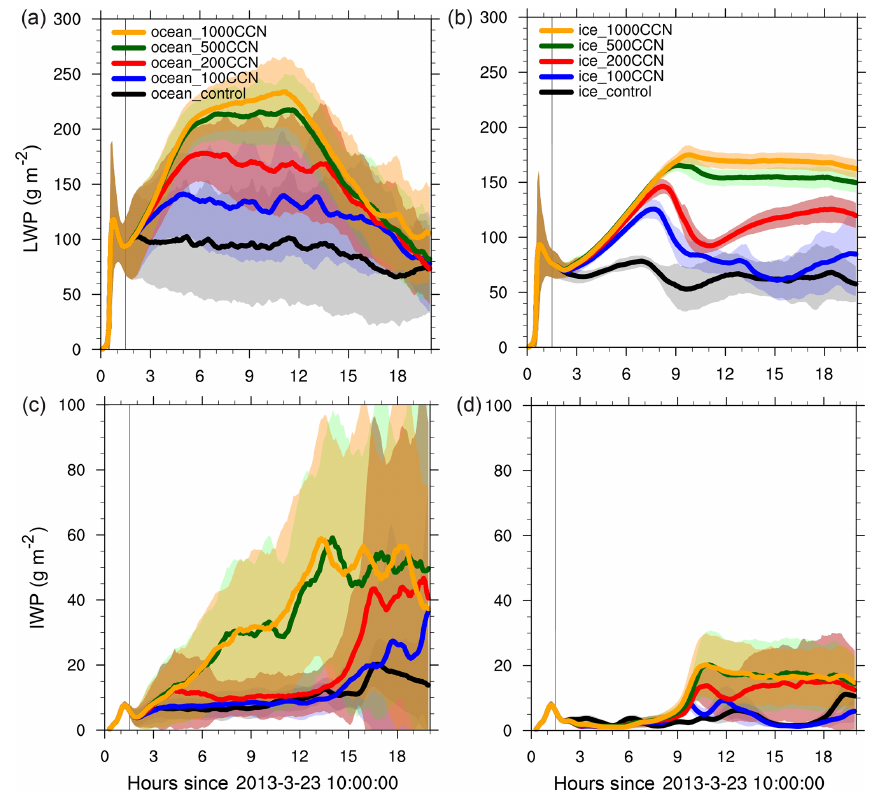
Figure 7. Domain-averaged (a, b) LWP and (c, d) IWP over the open ocean (a, c) and sea ice (b, d) in the control and all CCN sensitivity simulations. The solid lines depict the means, the shadings the standard deviations. The vertical black lines indicate the CCN perturbation